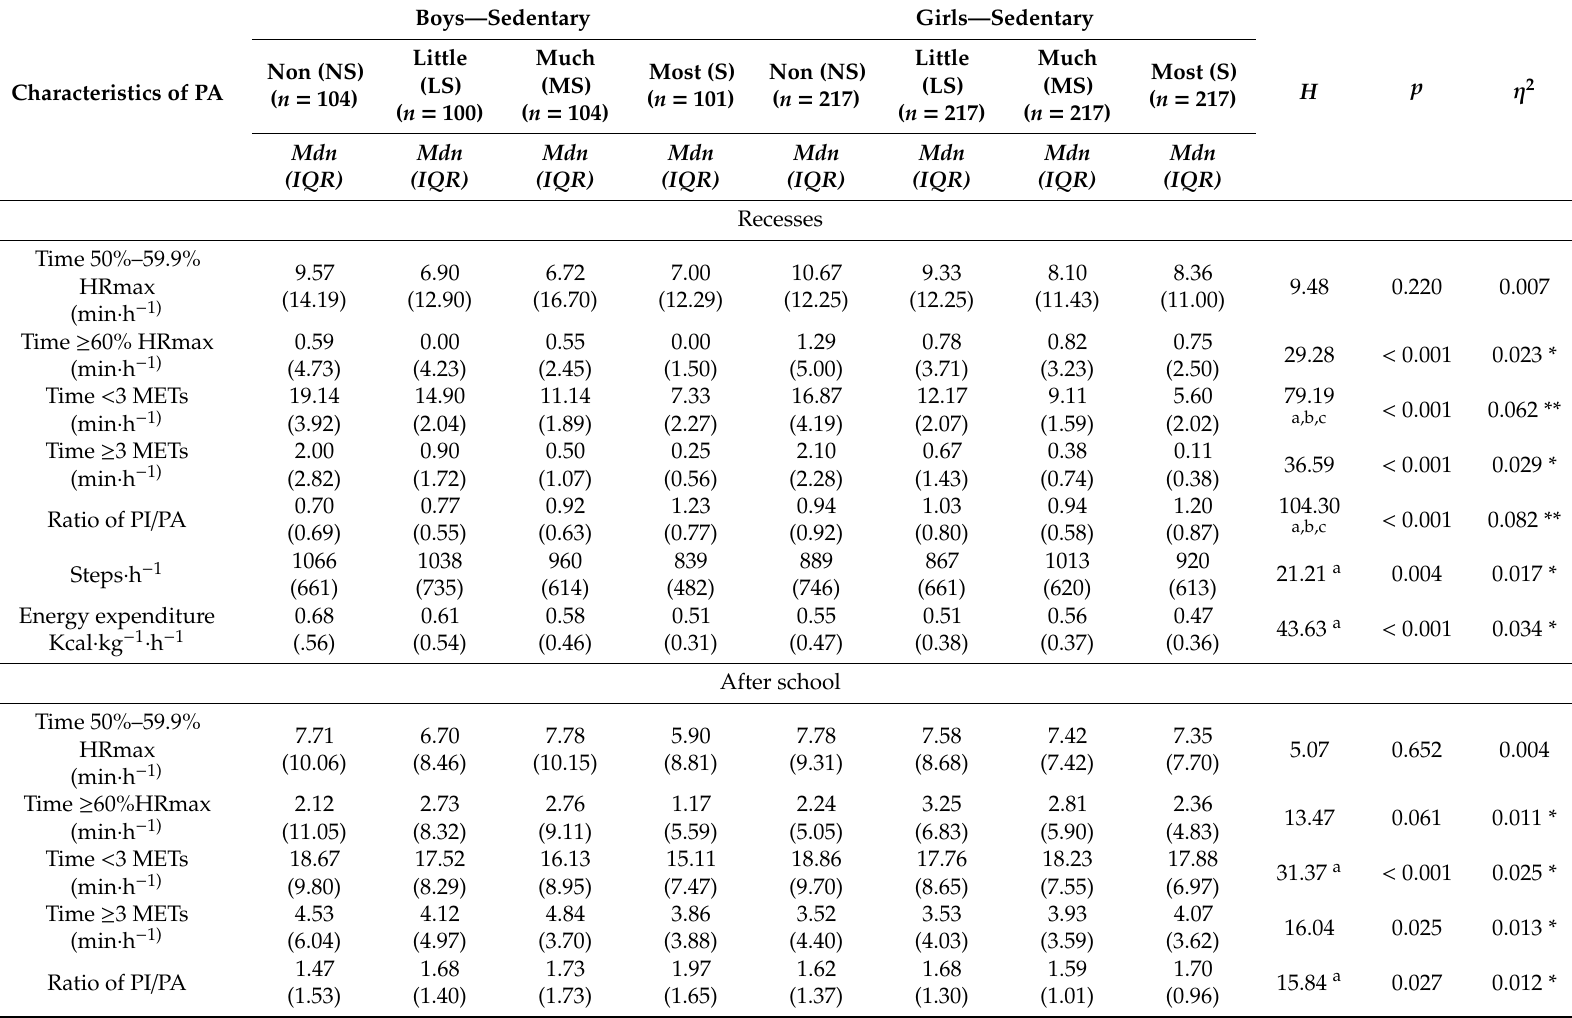
Table 2. Physical activity of sedentary and non-sedentary boys and girls during recesses, after school, and over the whole day.